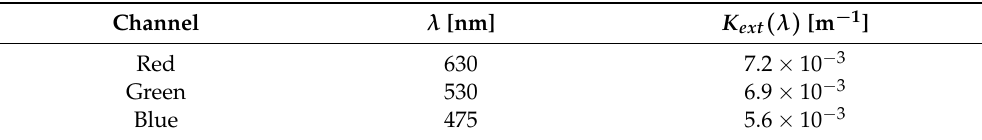
Table 4. Extinction coefficient values under sandstorm